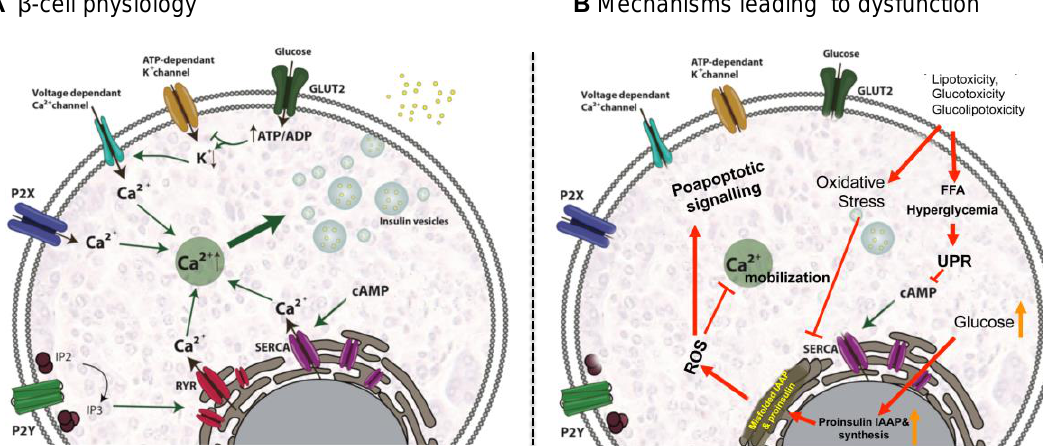
Figure 1. Signaling pathways involved in insulin secretion in β-cells in physiological conditions ( A ) and mechanisms leading to dysfunction ( B ). ( A ) Insulin release is primarily triggered by a response to high glucose concentrations and glucose in mainly internalized mainly through GLUT2 transporter. Glucose catabolism increases ATP/ADP ratio, ATP-dependant potassium channels are closed leading to membrane depolarization and opening of the voltage dependant Ca 2+ channels. The latter enables Ca 2+ influx triggering insulin exocytosis. Additional Ca 2+ channels as P2X, P2Y, SERCA and RYR contribute to Ca 2+ mobilization and insulin secretion. ( B ) hyperglycemia and hyperlipidemia promote oxidative stress leading to ROS generation that inhibits Ca 2+ mobilization and activates proapoptotic signals. Additionally, an excess of FFAs and hyperglycemia lead to the activation of the apoptotic unfolded protein response (UPR) pathways and generation of ER stress. Sustained high glucose levels increase proinsulin and IAAP biosynthesis, which generate ROS. GLUT2: glucose transporter 2, P2X: purinergic receptor X; P2Y: purinergic receptor Y; IP2: inositol 1,3-bisphosphate; IP3: inositol 1,4,5-trisphosphate; RYR: ryanodine receptor channel; SERCA: sarco-endoplasmic reticulum Ca 2+ -ATPase; FFA: free fatty acid, ROS: reactive oxygen species; UPR: unfolded protein response.